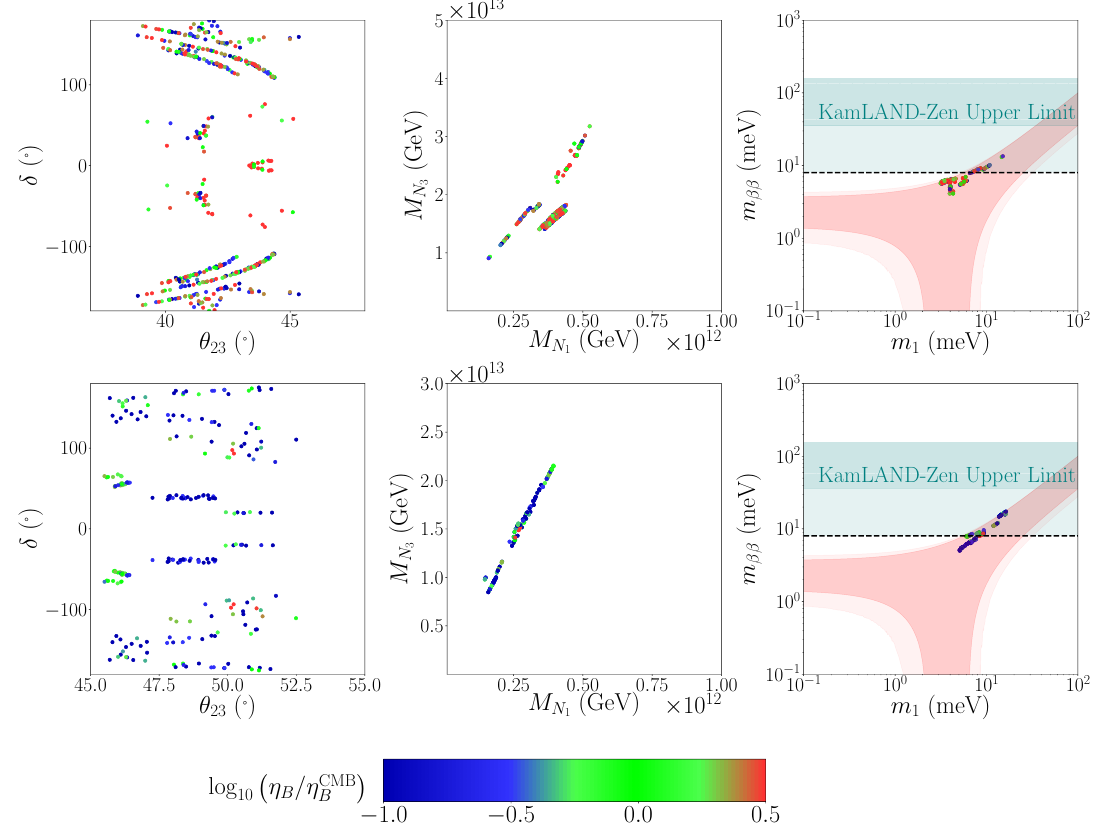
Figure 6 . The top (bottom) left and centre panels are the two-dimensional correlations between predicted observables for χ 2 < 10 and θ shows the predictions for the effective neutrino mass for θ points denotes the ratio of the predicted baryon-to-photon ratio to the experimentally observed best-fit value as measured using CMB data η CMB unification is considered. In the leftmost plots, the dashed line labels the sensitivity of the next generation experiments on 0 νββ